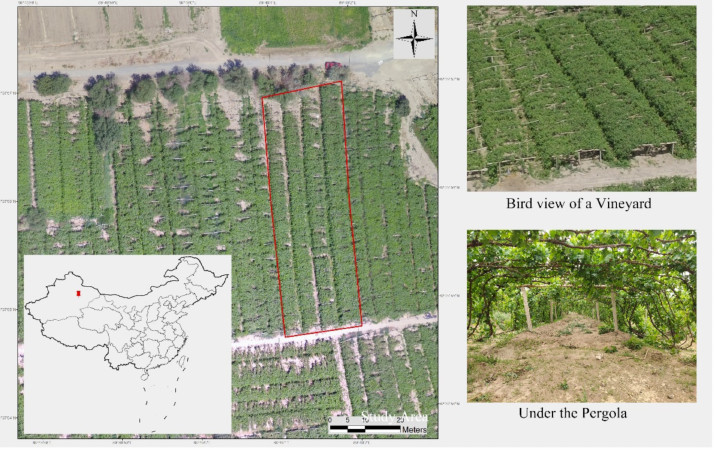
Figure 1. Location of study area, birds eye view of a vineyard, and a scene below the